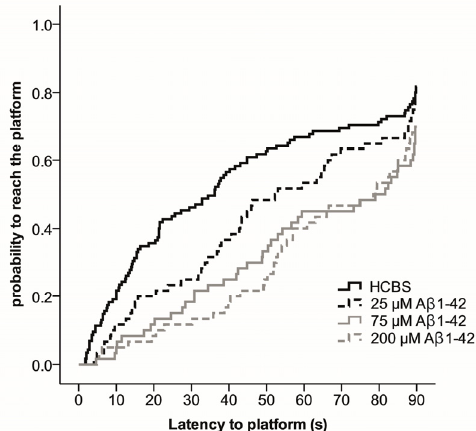
Figure 9. Effect of different aggregation concentrations (25, 75 and 200 µ M) of synthetic A β 1-42 (24 h aggregation time) on Morris water maze performance. The fitted survival curves using the Cox Proportional Hazard model represents the probability that animals find the platform during a trial, capped at 90 s. We compared HCBS vs. 25 µ M oA β 1-42 ( p = 0.219), HCBS vs. 75 µ M oA β 1-42 ( p = 0.003), and HCBS vs. 200 µ M oA β 1-42 ( p = 0.001) treatment groups using log-rank tests ( n = 12/group, except the HCBS group, where n = 23).